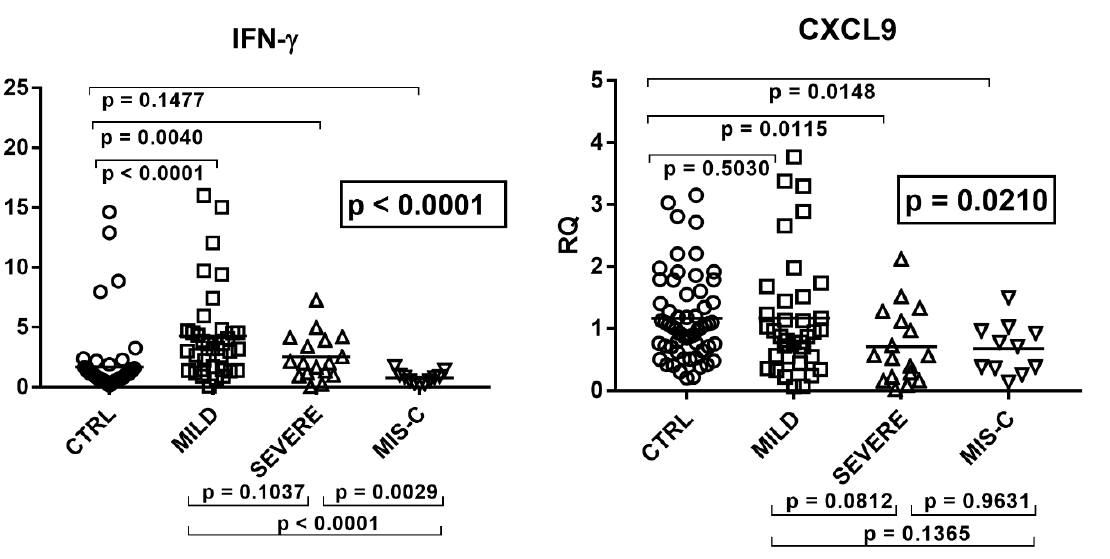
four groups of children. The Mann–Whitney test was used to compare the transcriptional levels of each target between each group of children with each other.